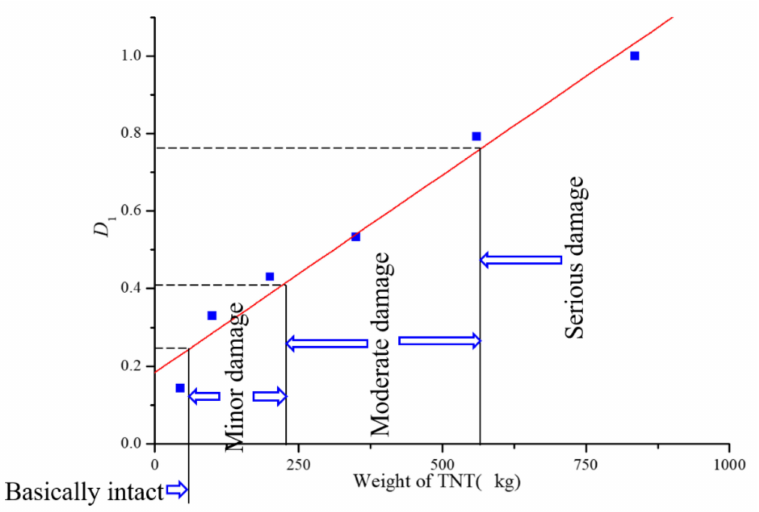
Figure 8. Degree of the damage to surface flood discharge holes for different masses of